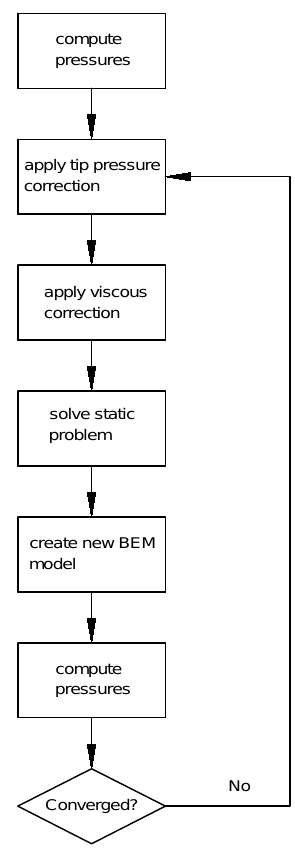
Figure 3. Flow chart of BEM-FEM